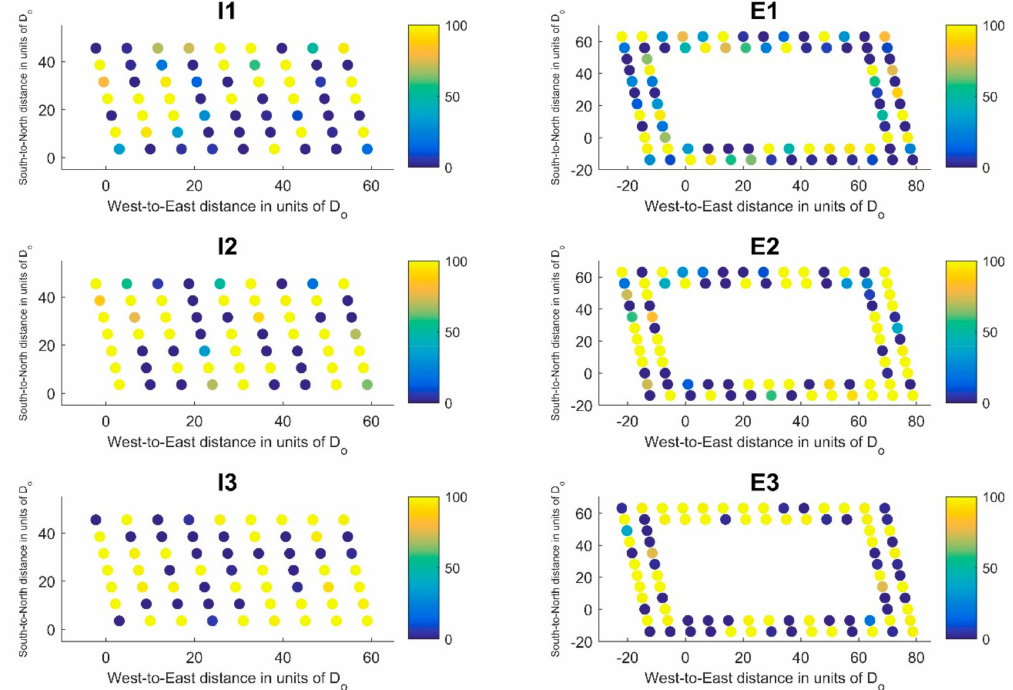
Figure 13. Coe ffi cient of height, C H , distribution for multiple turbines grid